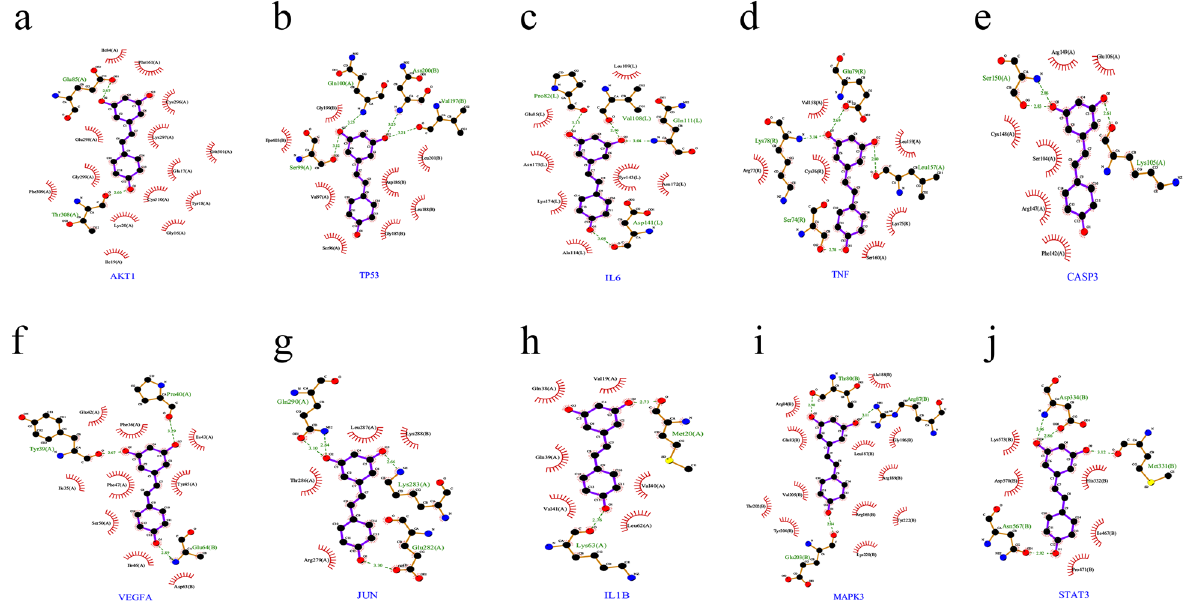
Figure 6. Docking pattern of Que with key target molecules. ( a ) IL-6 and Que molecular docking; ( b ) VEGFA and Que molecular docking; ( c ) JUN and Que molecular docking; ( d ) MMP9 and Que molecular docking; ( e ) EGFR and Que molecular